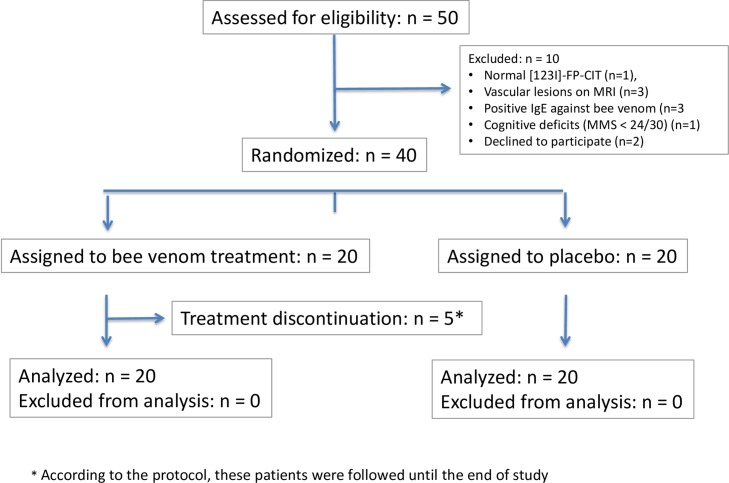
Study Flowchart.